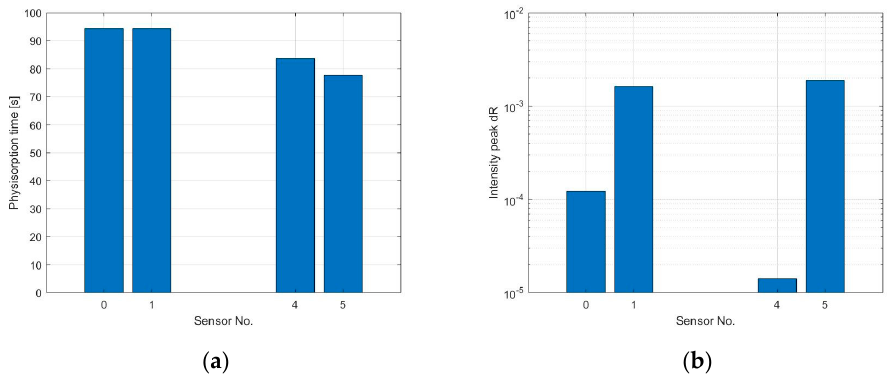
Figure 12. ( a ) Physisorption time of sensors S 0 , S 1 , S 4 , and S 5 when exposed to 10 ppm NH3, calculated using the first derivative approach; ( b ) Intensity of the peak of the first derivative of the sensor’s signal during the physisorption. This value has been used to compare the response speed of the different